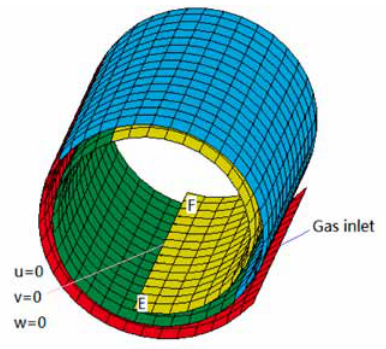
Fig. 8. Finite element model of a rolled tube